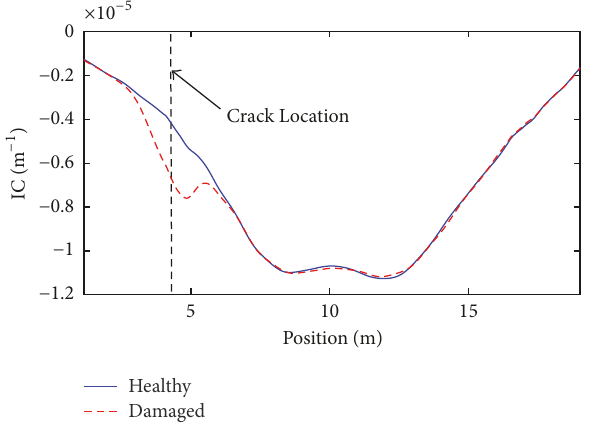
Figure 7: IC at the moving